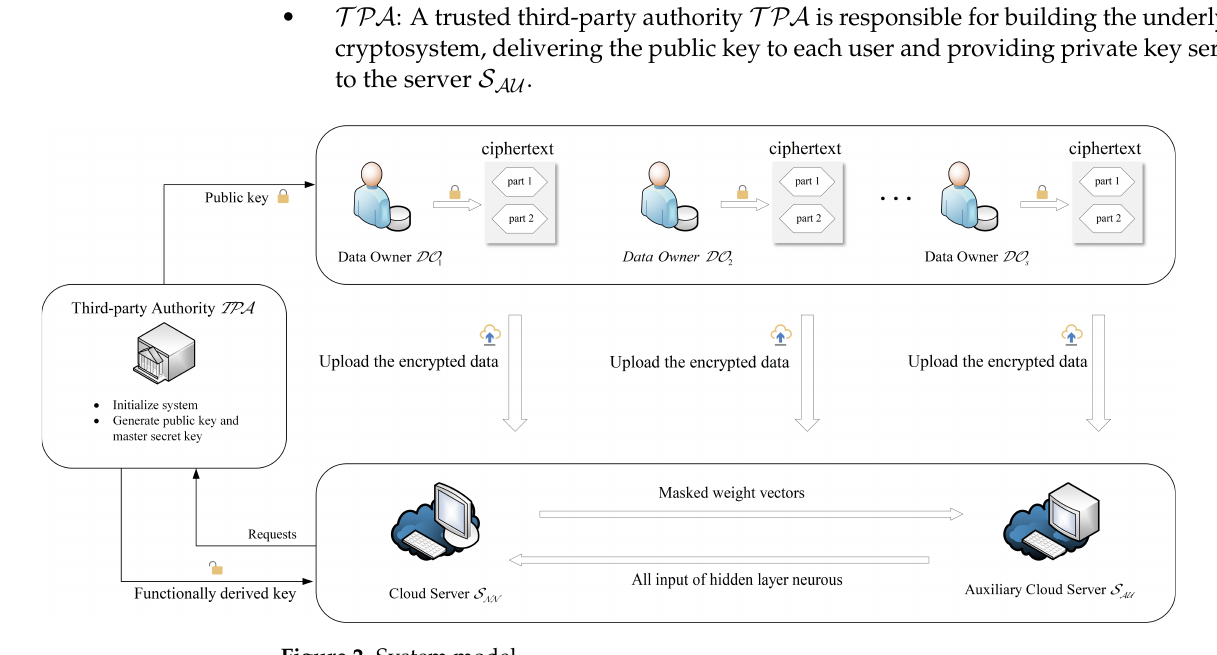
Figure 2. System